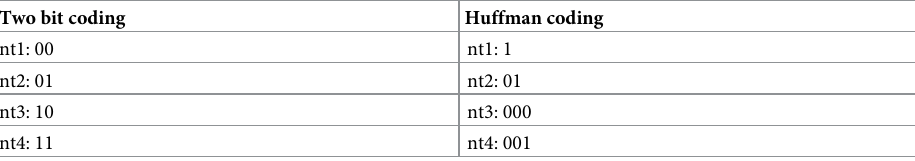
Table 1. Coding scheme for DDQR